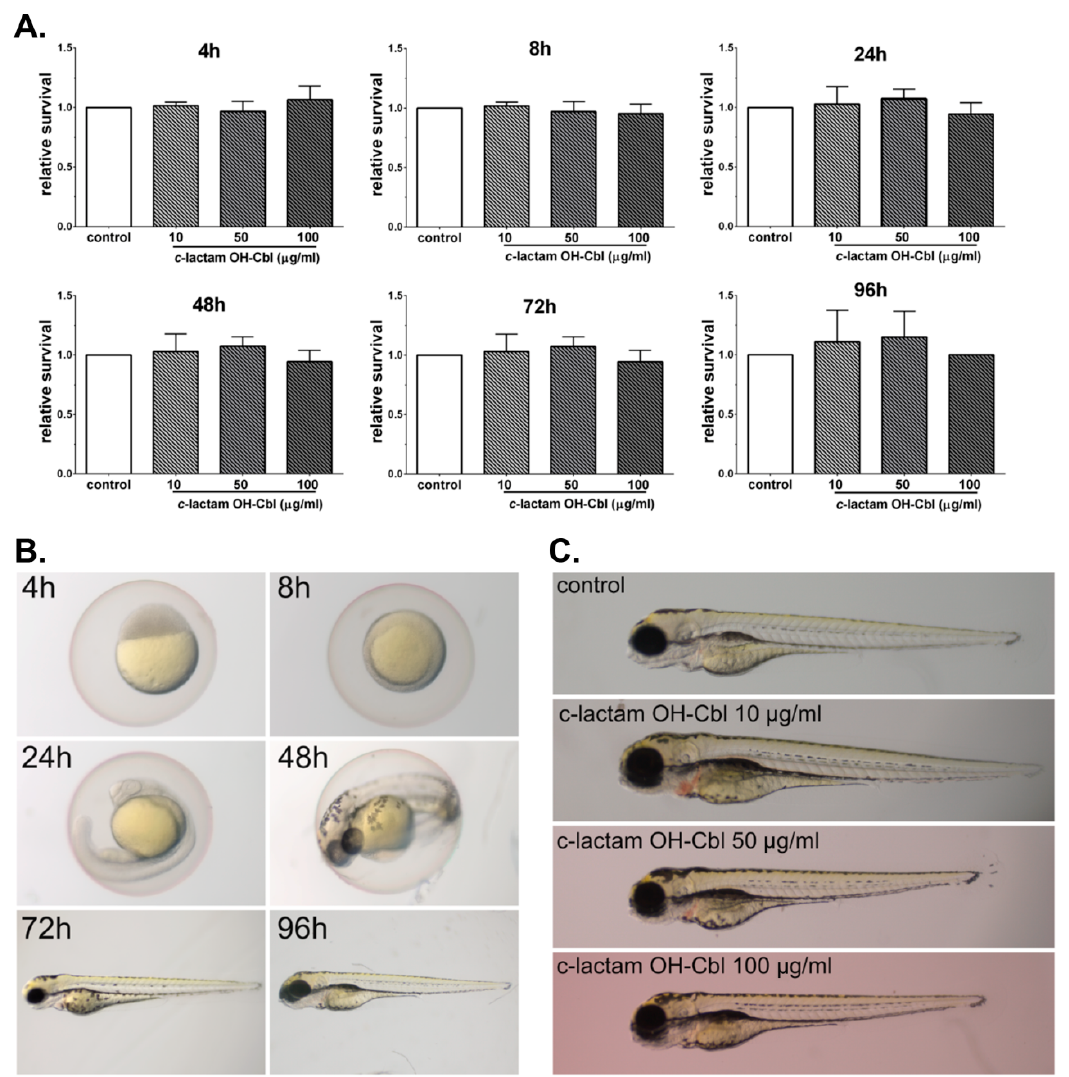
Figure 4. The lack of biotoxicity of c -lactam OH-Cbl on zebrafish. ( A ) Relative survival in zebrafish exposed to c -lactam OH-Cbl (10, 50 and 100 µg/mL) at 4, 8, 24, 48, 72 and 96 hpf. Data are mean ± SD, n = 8. ( B ) The development of zebrafish embryo at 4, 8, 24, 48, 72 and 96 hpf. ( C ) Effects of different c -lactam OH-Cbl concentrations (10, 50 and 100 µg/mL) on the pigmentation in zebrafish at 96 hpf.